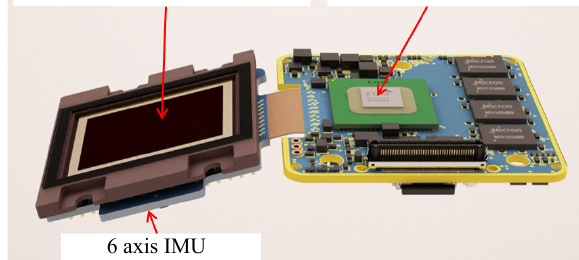
6 axis IMU Figure 2. The CMOS Sensor with the inertial sensors and the embedded intelligence (SoC/FPGA).